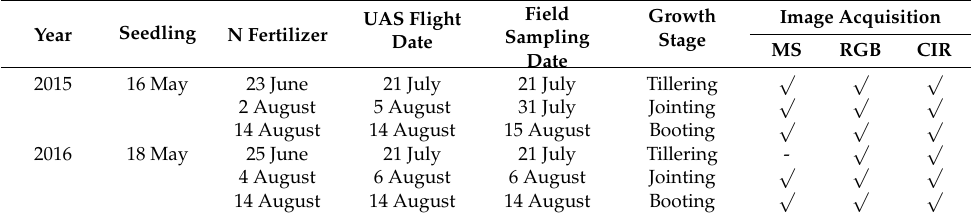
Note: MS, RGB and CIR represent multispectral, red–green–blue and color infrared.